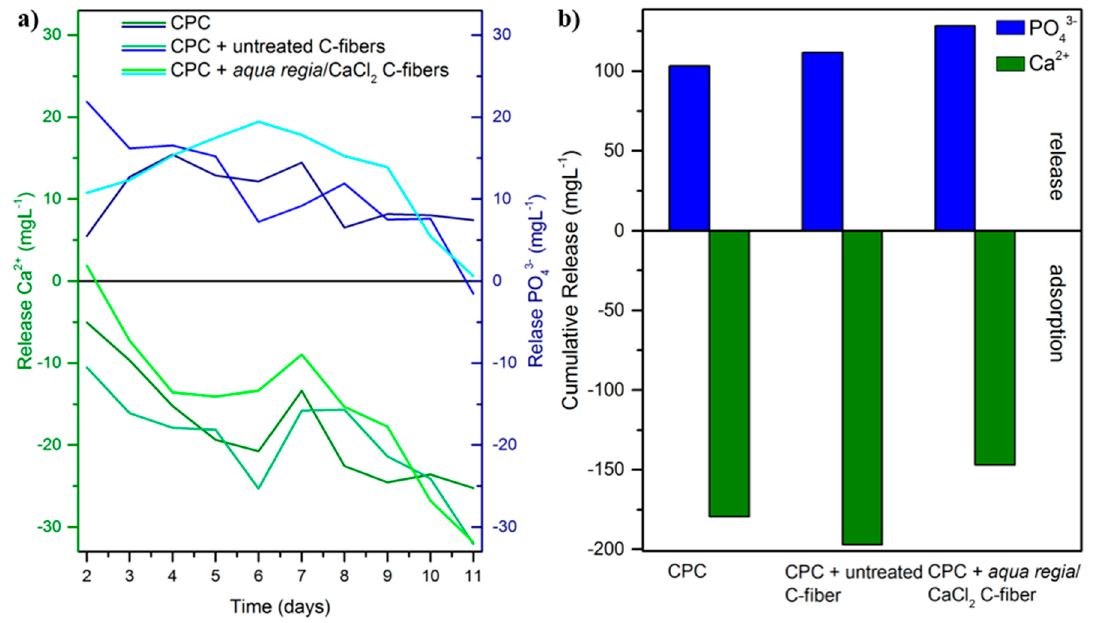
Figure 7. ( a ) Ca 2+ and PO 43 − release during dissolution of calcium phosphate cement (CPC) with and without fiber-reinforcement, as well as ( b ) cumulative release and adsorption, respectively, over a dissolution period of 11 days.